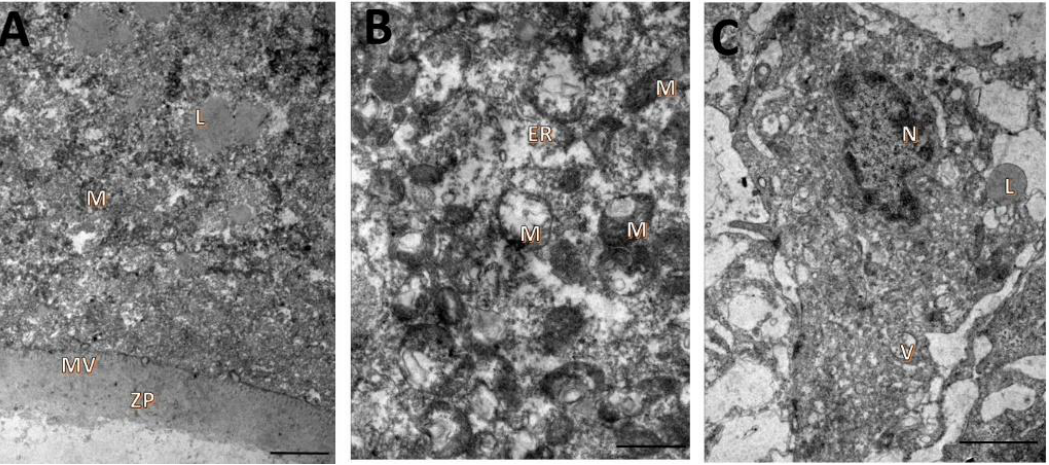
Figure 2. Ultrastructural characteristics of oocytes ( A , B ) and granulosa cells ( C ) from uncultured secondary follicles. Mitochondria (M), zona pellucida (ZP), nucleus (N), lipid droplets (L), vacuoles (V), microvillous (MV), endoplasmic reticulum (ER). Scale bar = 100 µm.